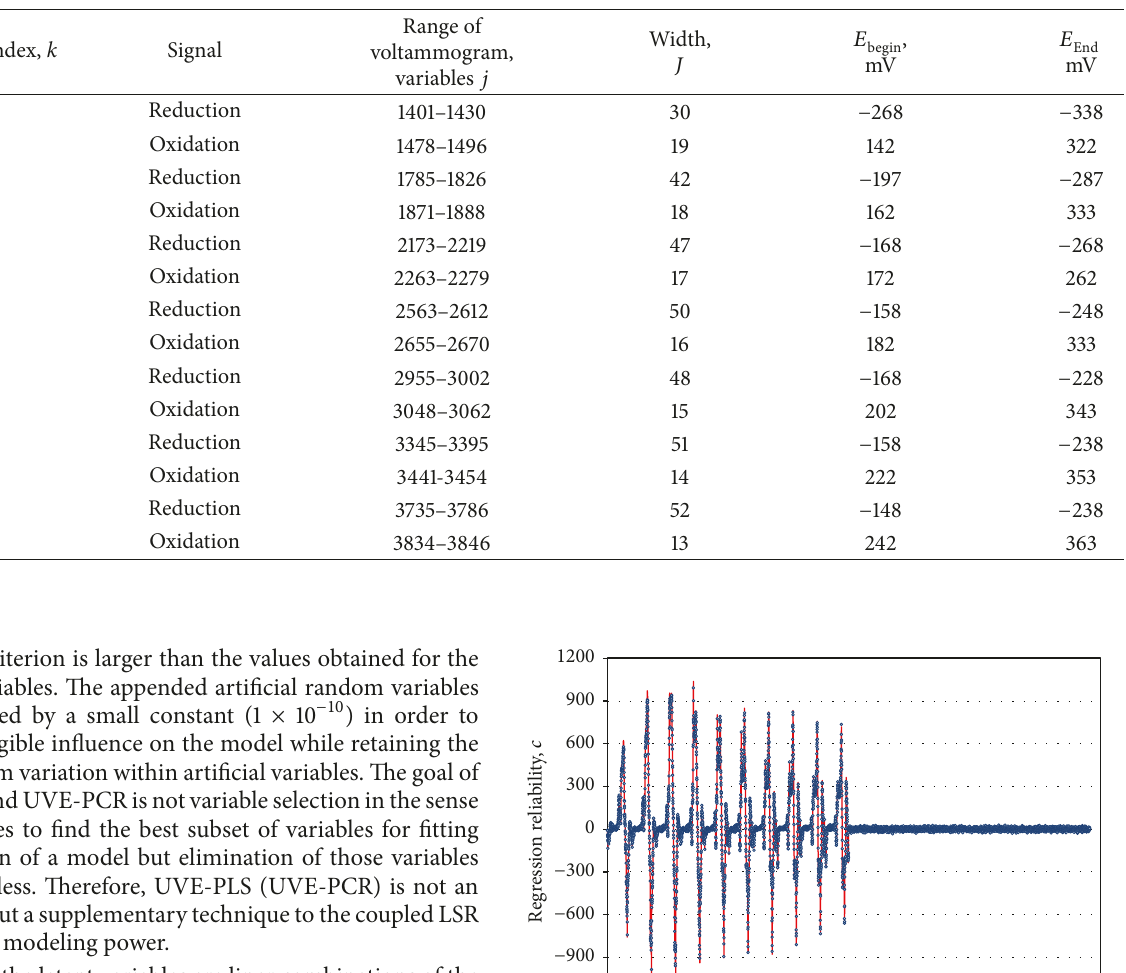
reference electrode. Cu 2+ / Cu